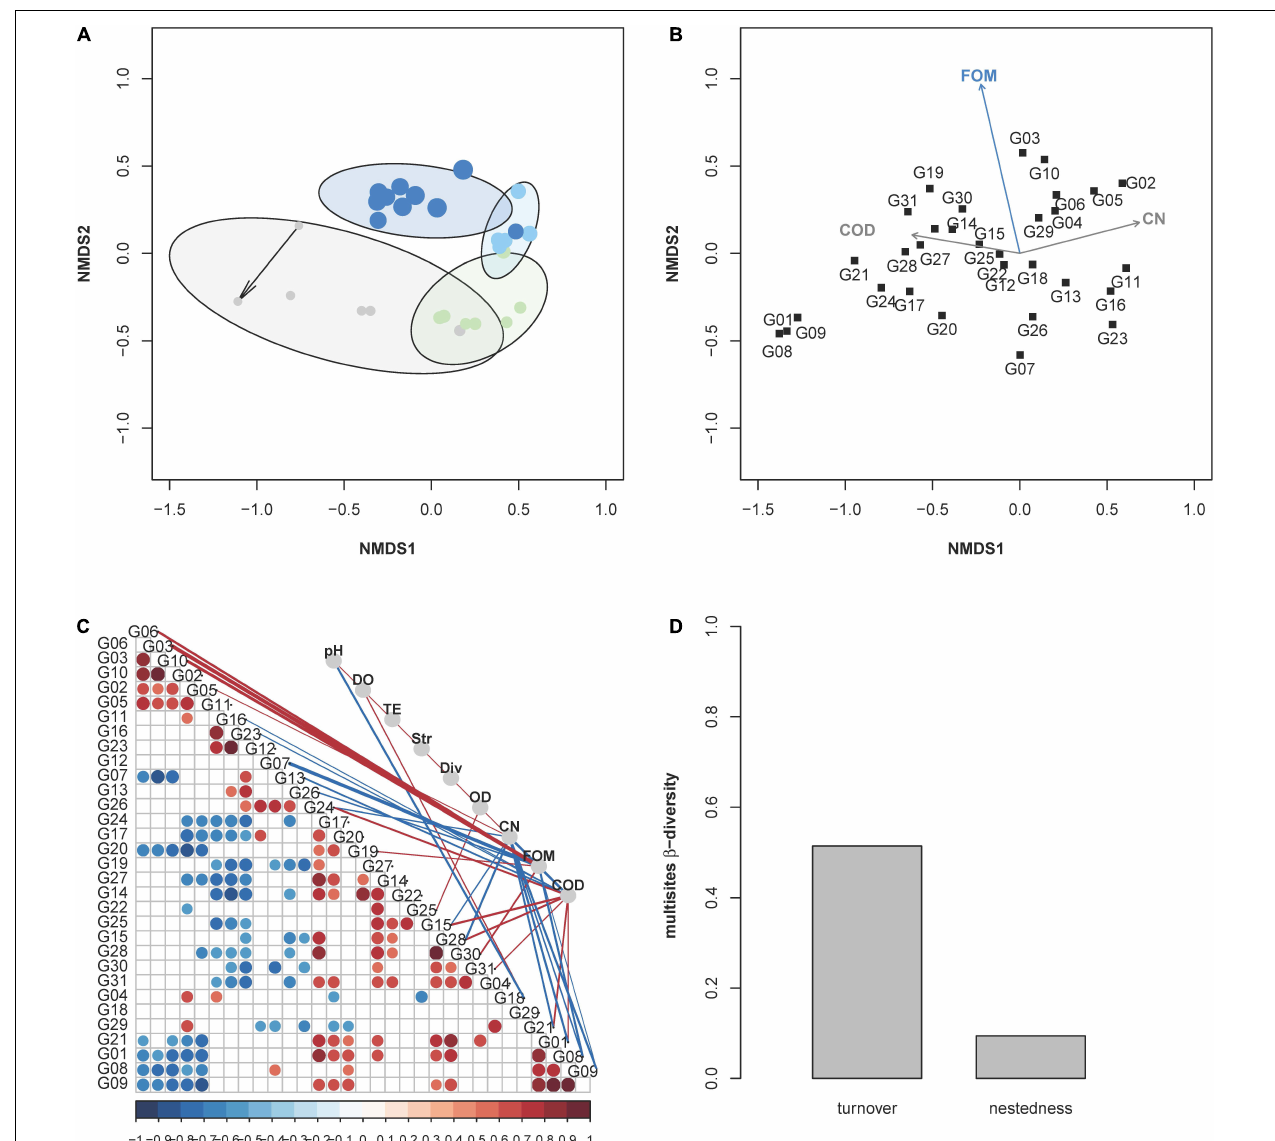
FIGURE 3 | Trends in community evolution depending on fosfomycin concentrations. (A) The assembly process of the microbial community in the bioreactor was visualized via a NMDS plot based on the dissimilarity analysis (Bray–Curtis index) of relative cell abundance per subcommunity. Each point in the NMDS plot represent a whole community sample, and the increase in its sampling time was represented by the increased point size. Points were colored according to the sampling phases, and the starting point was marked by an arrow. The experiment was subgrouped in four phases—gray, adaptation; green, gfp-labeled P. putida KT2440 augmentation; light blue, fosfomycin 10 mg L − 1 ; blue, fosfomycin 268 mg L − 1 (details in Table 1 ). (B) Relationship between abiotic parameters and abundance variations of subcommunities (R function “envfit” from the vegan package); only significant correlations of | rho | > 0.7 and p -value < 0.05 were displayed such as FOM, CN, and COD. (C) Relationship between subcommunities and environmental parameters. The correlation was performed using Spearman rank index rho . Only significant correlations | rho | > 0.5 and p -value < 0.05 were displayed. The strengths of the correlation values were indicated by the size of points (subcommunities vs. subcommunities) or the thickness of the edges (subcommunities vs. environmental parameters) and by the color code below the x -axis (red: positive, blue: negative). Explanation of abbreviations: pH, DO (dissolved oxygen concentration), T (temperature), Str (stirring), Div (order-based Hill number q =